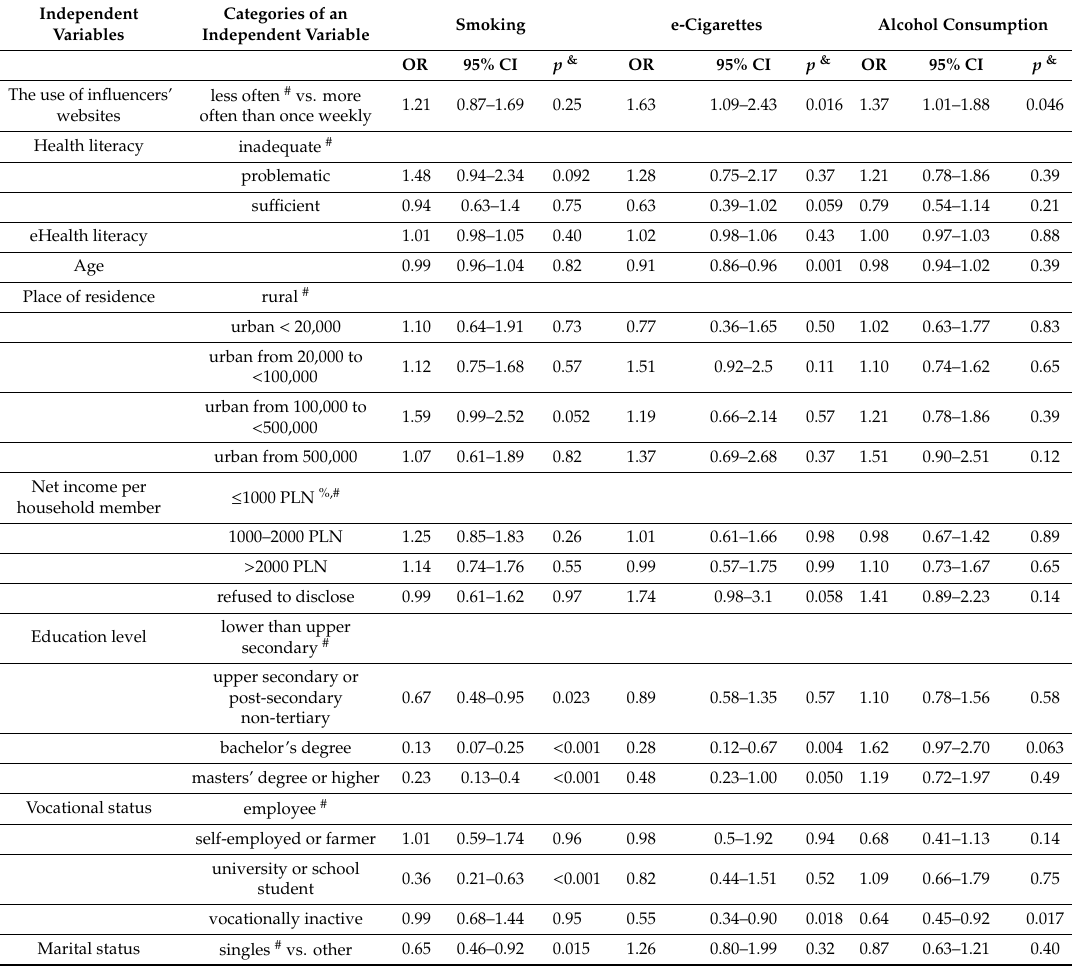
Table 4. Multivariate logistic regression model for smoking, the use of e-cigarettes, and alcohol consumption as dependent variables.